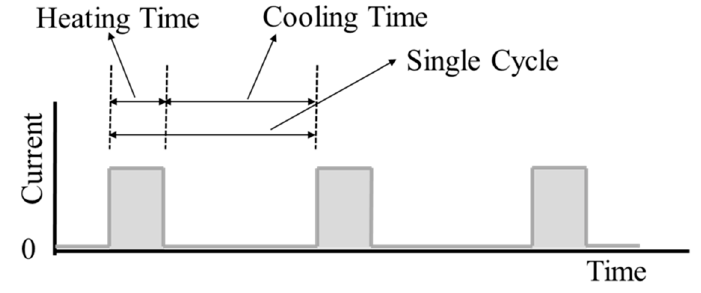
Figure 6. Input signal description.